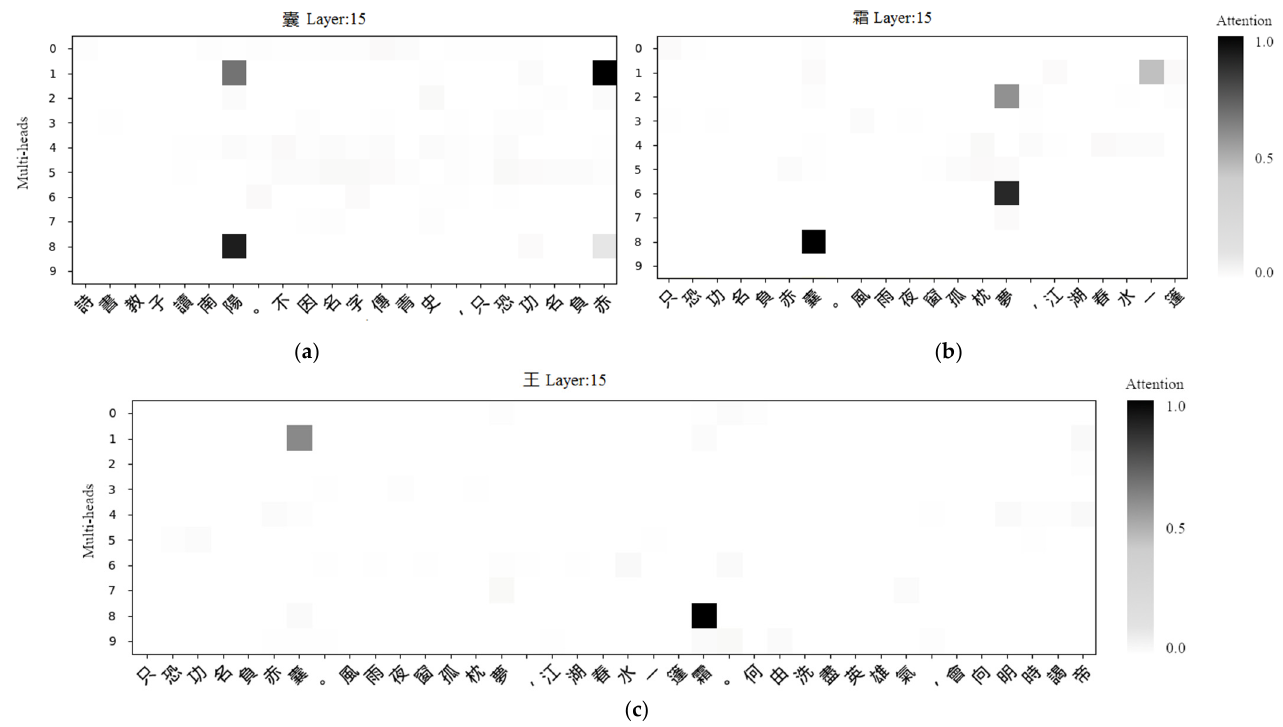
Figure 10. Visualization of the rhyming-rule. ( a ) bag ( 囊 ); ( b ) frost ( 霜 ); ( c ) monarch ( 王 )